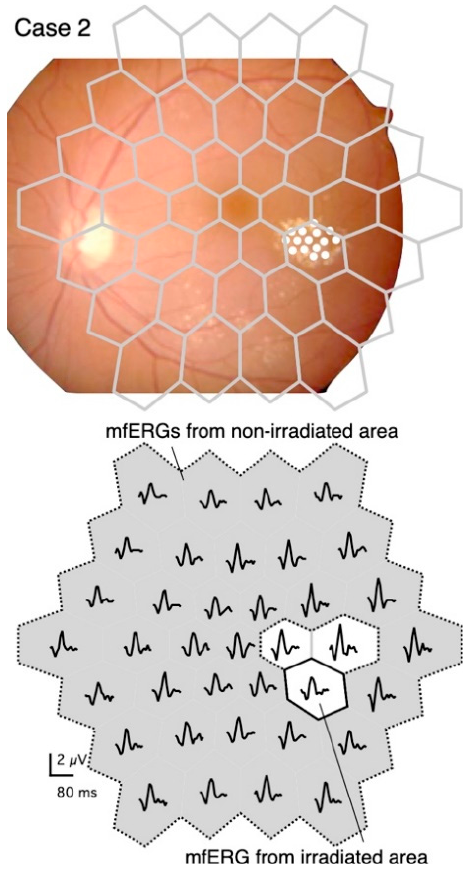
Figure 1. Stimulus pattern superimposed on a fundus image, and distribution of multifocal elec- troretinograms (mfERGs) recorded at different retinal sites. Upper panel: Diagram of stimulus consisting of 37 stimulus hexagons superimposed on the fundus of Case 2. The fundus image is flipped vertically to correspond to the